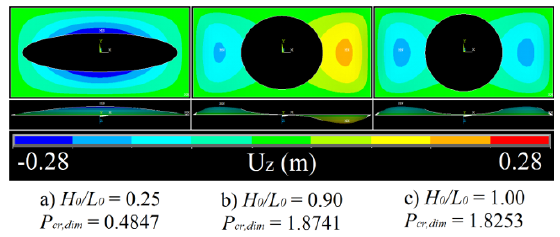
Figure 9. Buckled shape of rectangular perforated plate with hole volume fraction of 0.40.